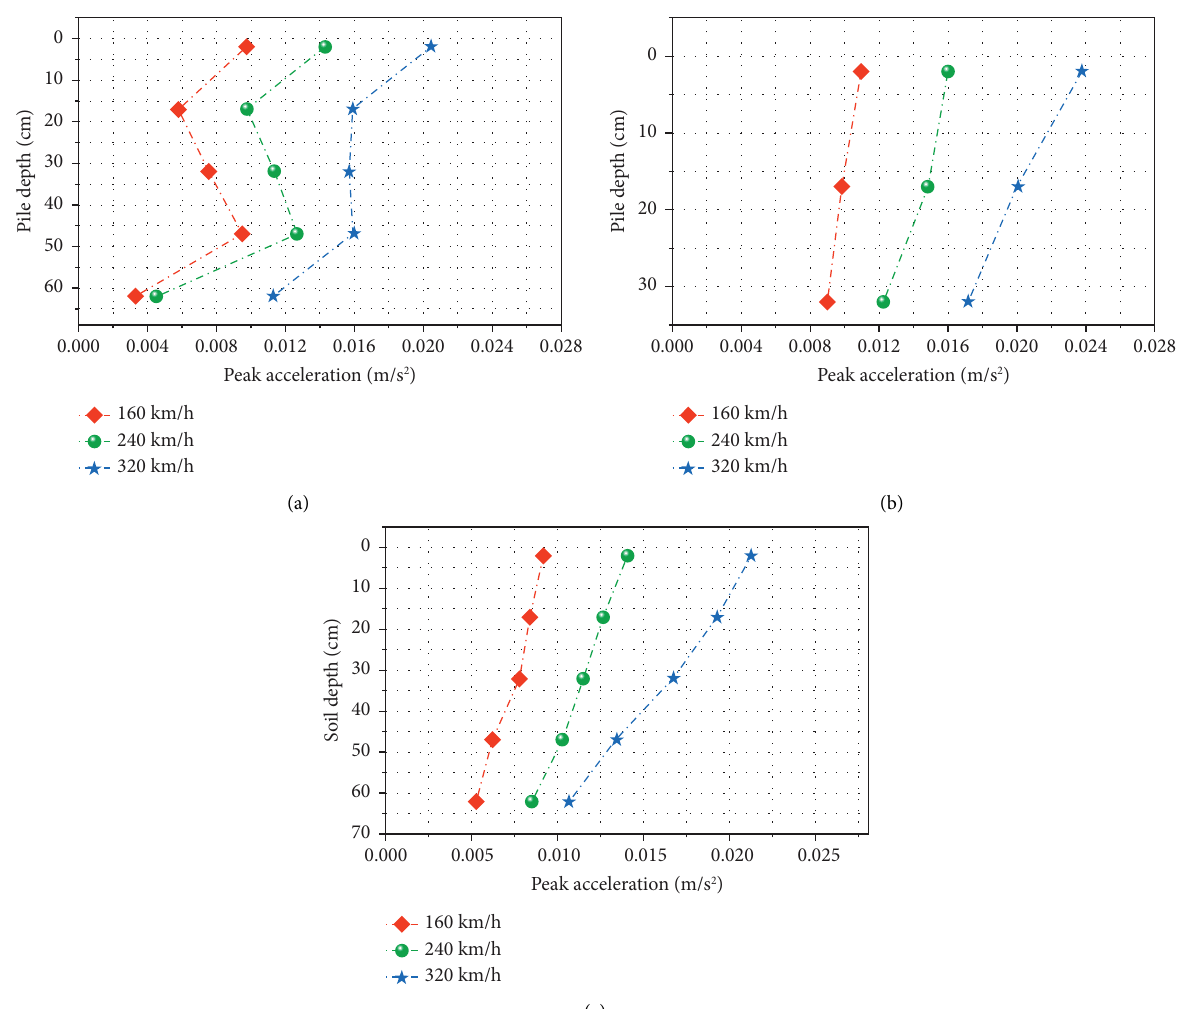
Figure 6: Peak distribution curve of acceleration response. (a) Peak acceleration response distribution of long piles. (b) Peak acceleration response distribution of short piles. (c) Peak acceleration response distribution of soil between